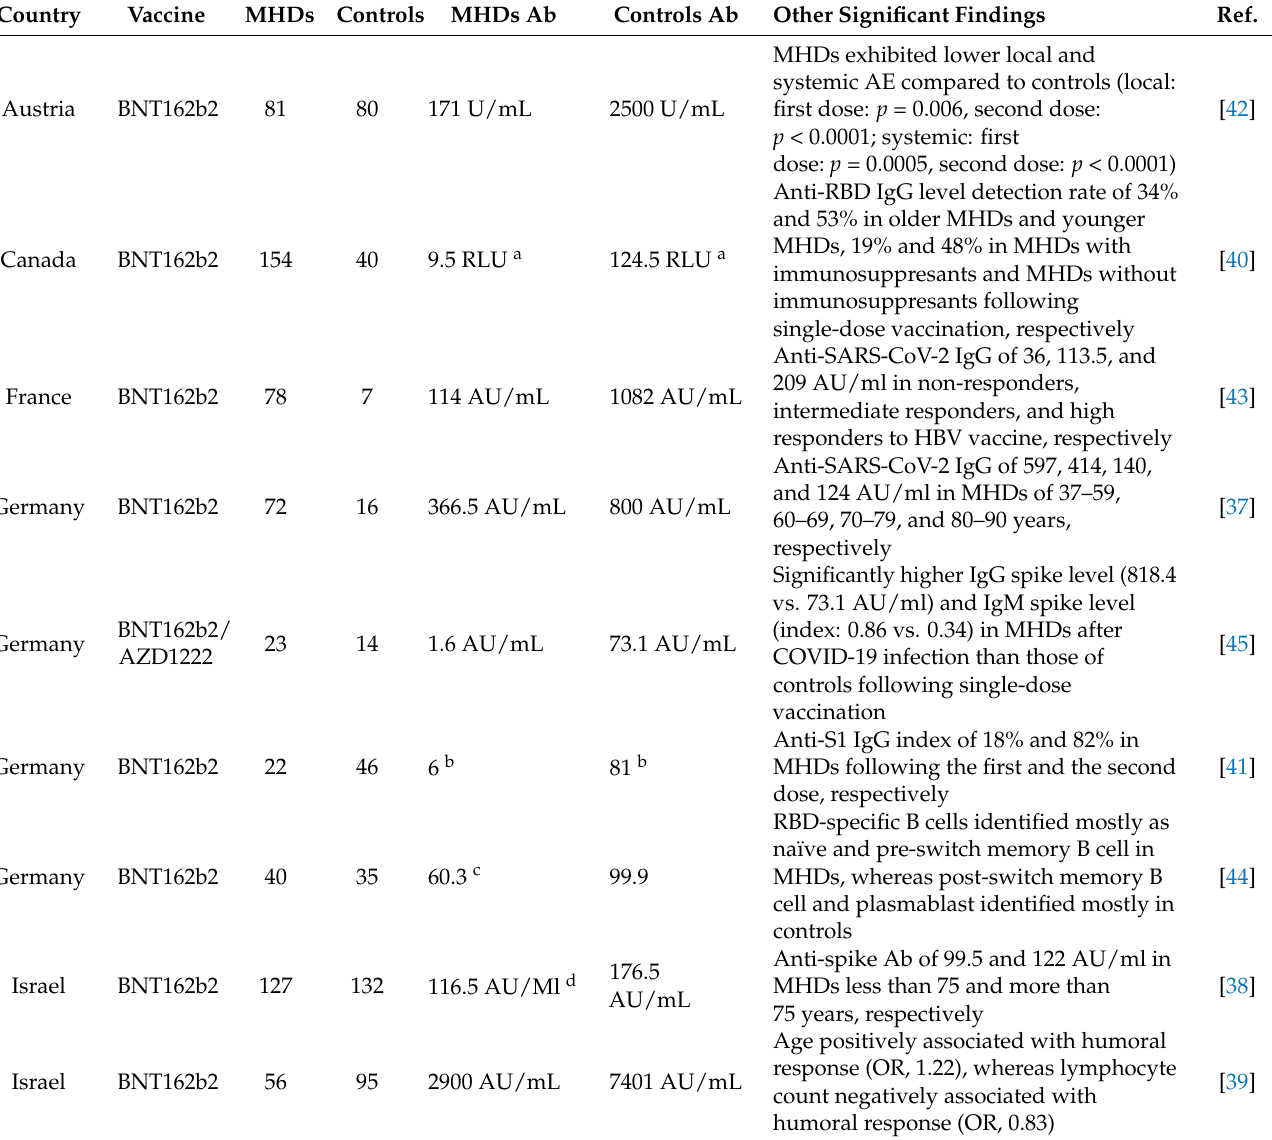
Table 2. Comparison of effectiveness following COVID-19 vaccination between patients with MHD and healthy